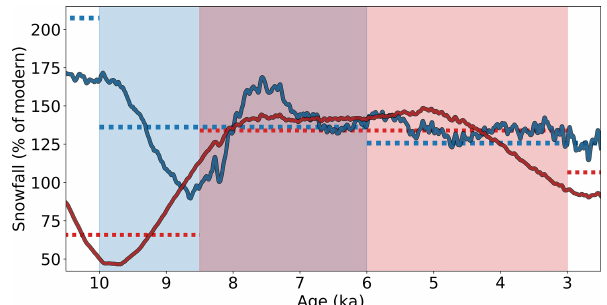
Figure 9. HTM snowfall averaged across the northern and south- ern flow lines for the Buizert et al. (2018) (solid blue line) and Dahl-Jensen et al. (1998) (solid red line) inversions. Shaded blue and pink regions demarcate the extent of the HTM for the Buizert et al. (2018) and Dahl-Jensen et al. (1998) reconstructions, respec- tively. Dashed lines show pre-HTM, HTM, and post-HTM average snowfall for each inversion.